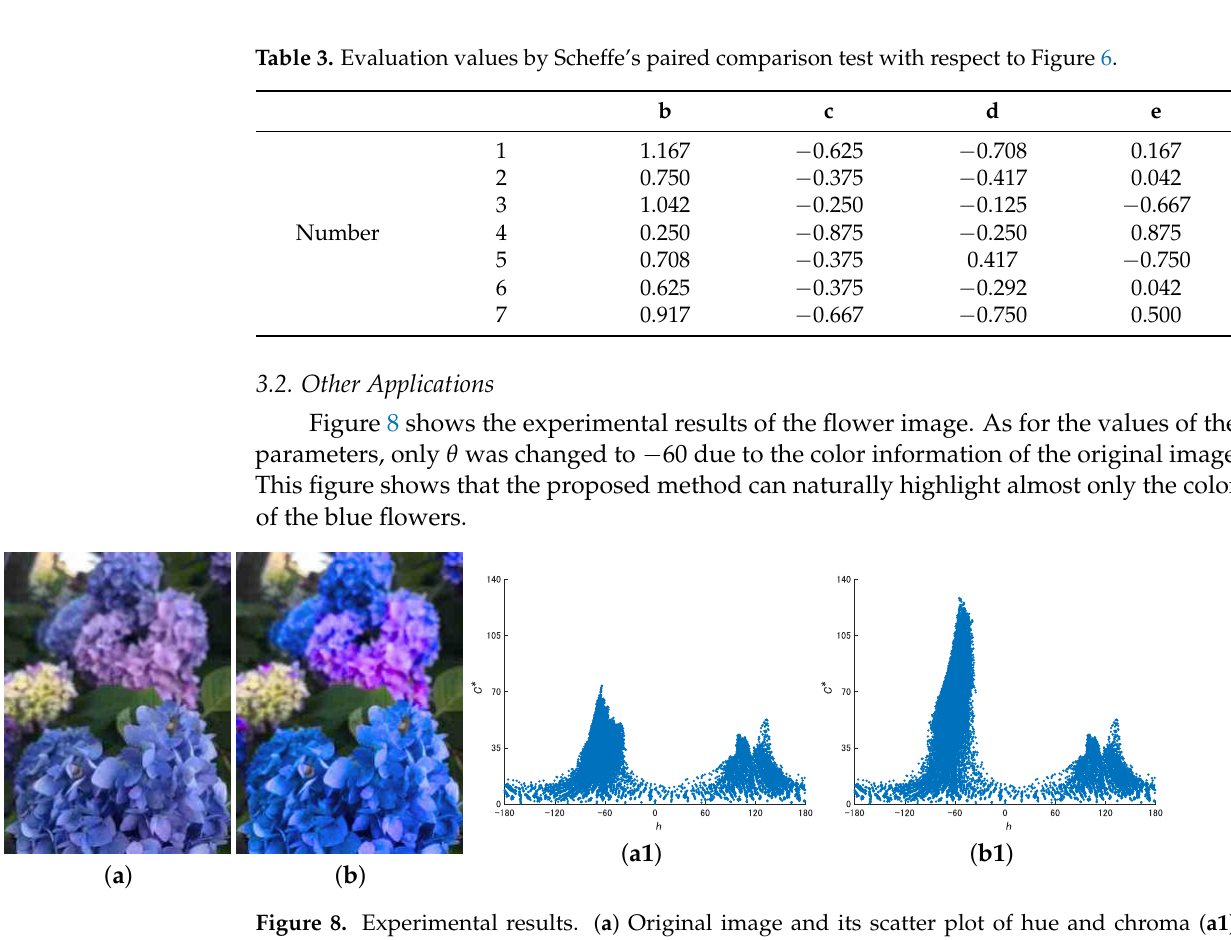
Figure 8. Experimental results. ( a ) Original image and its scatter plot of hue and chroma ( a1 ). ( b ) Resulting image using the proposed method with Equation (6) and its scatter plot of hue and chroma ( b1